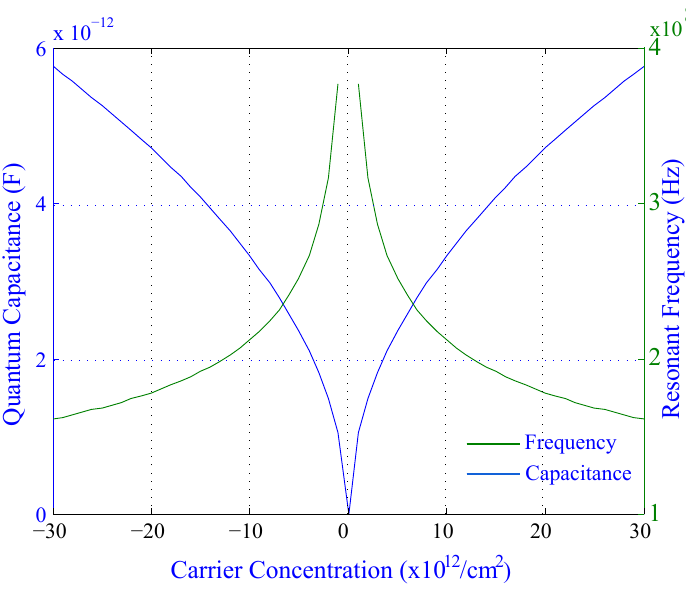
Figure 11. Effect of carrier concentration on the quantum capacitance as well as resonant frequency for